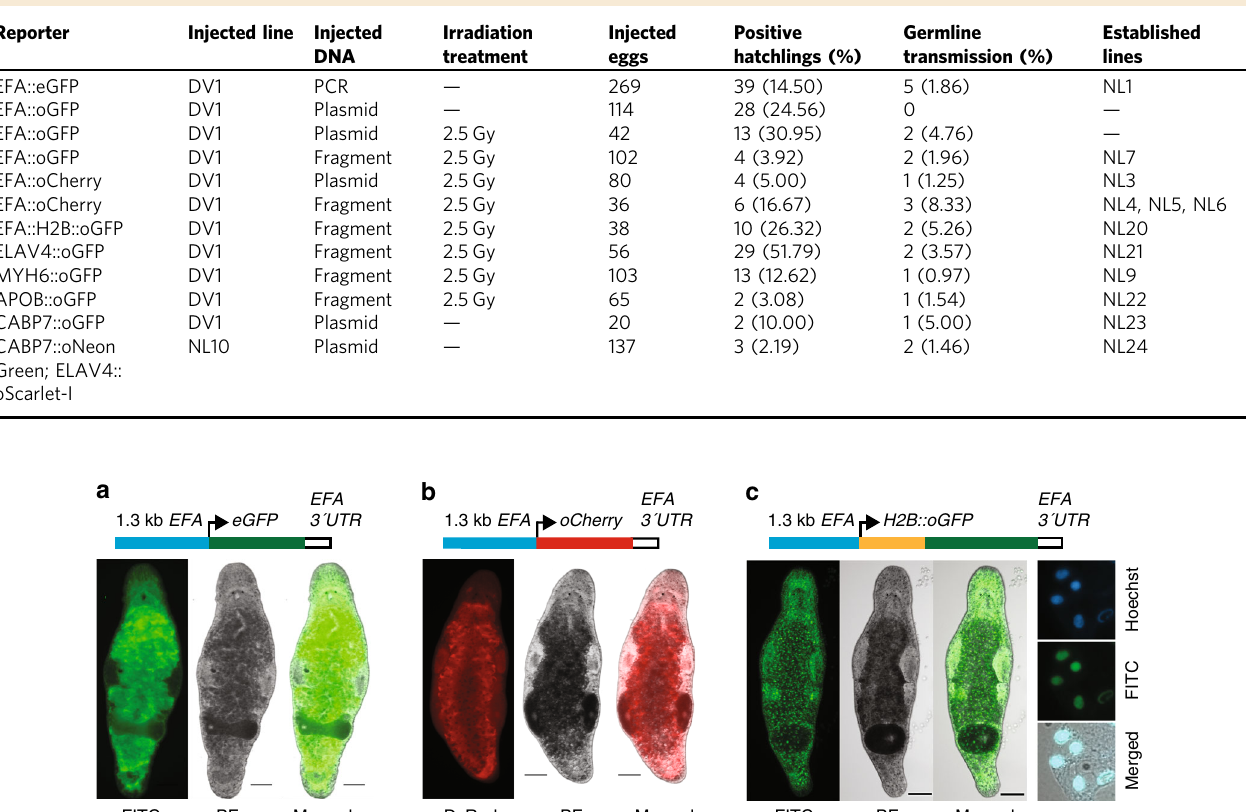
NATURE COMMUNICATIONS | DOI: